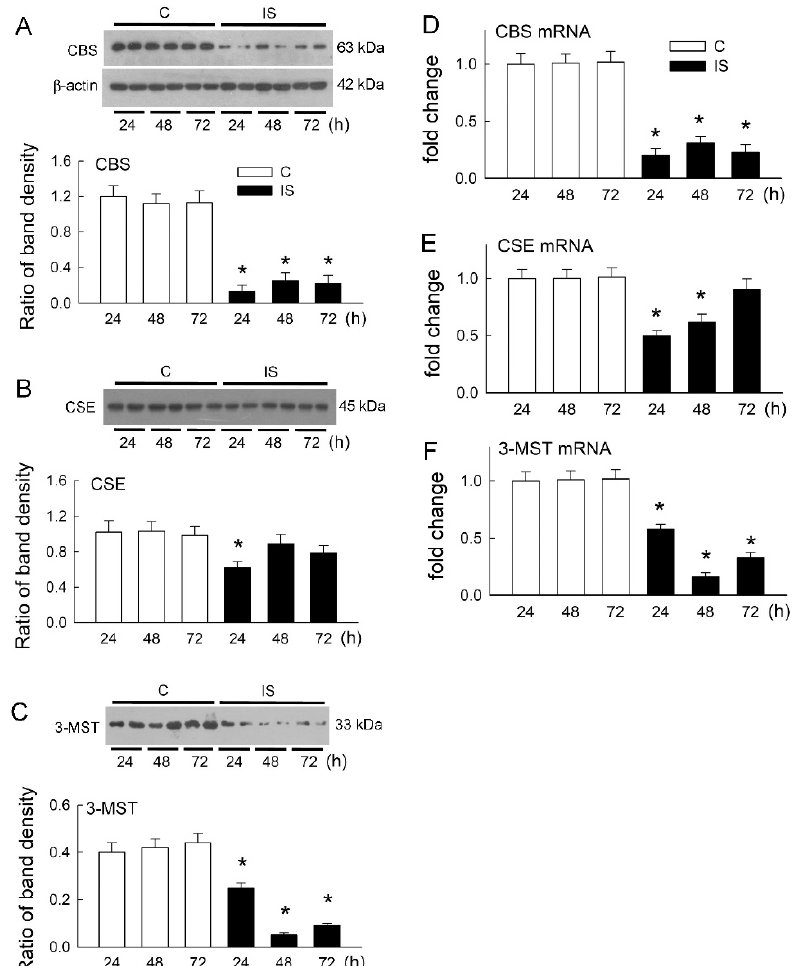
Figure 4. IS lowered the expression of H 2 S-producing enzymes. ( A – C ) The representative blots show two independent samples for the protein expression of CBS ( A ), CSE ( B ), and 3-MST ( C ) in cells after 24, 48, and 72 h of treatment with the vehicle solution (C, control) or IS. The lower bar graphs show the ratio of the band density of H 2 S-producing enzymes to β -actin. N = 6 in each group and time-point. ( D – F ) The mRNA expression of CBS ( D ), CSE ( E ), and 3-MST ( F ) in control cells and cells treated with IS was examined by RT-qPCR. N = 6 in each group and time-point. * p < 0.05, IS vs. control (C) group at the same time-point.